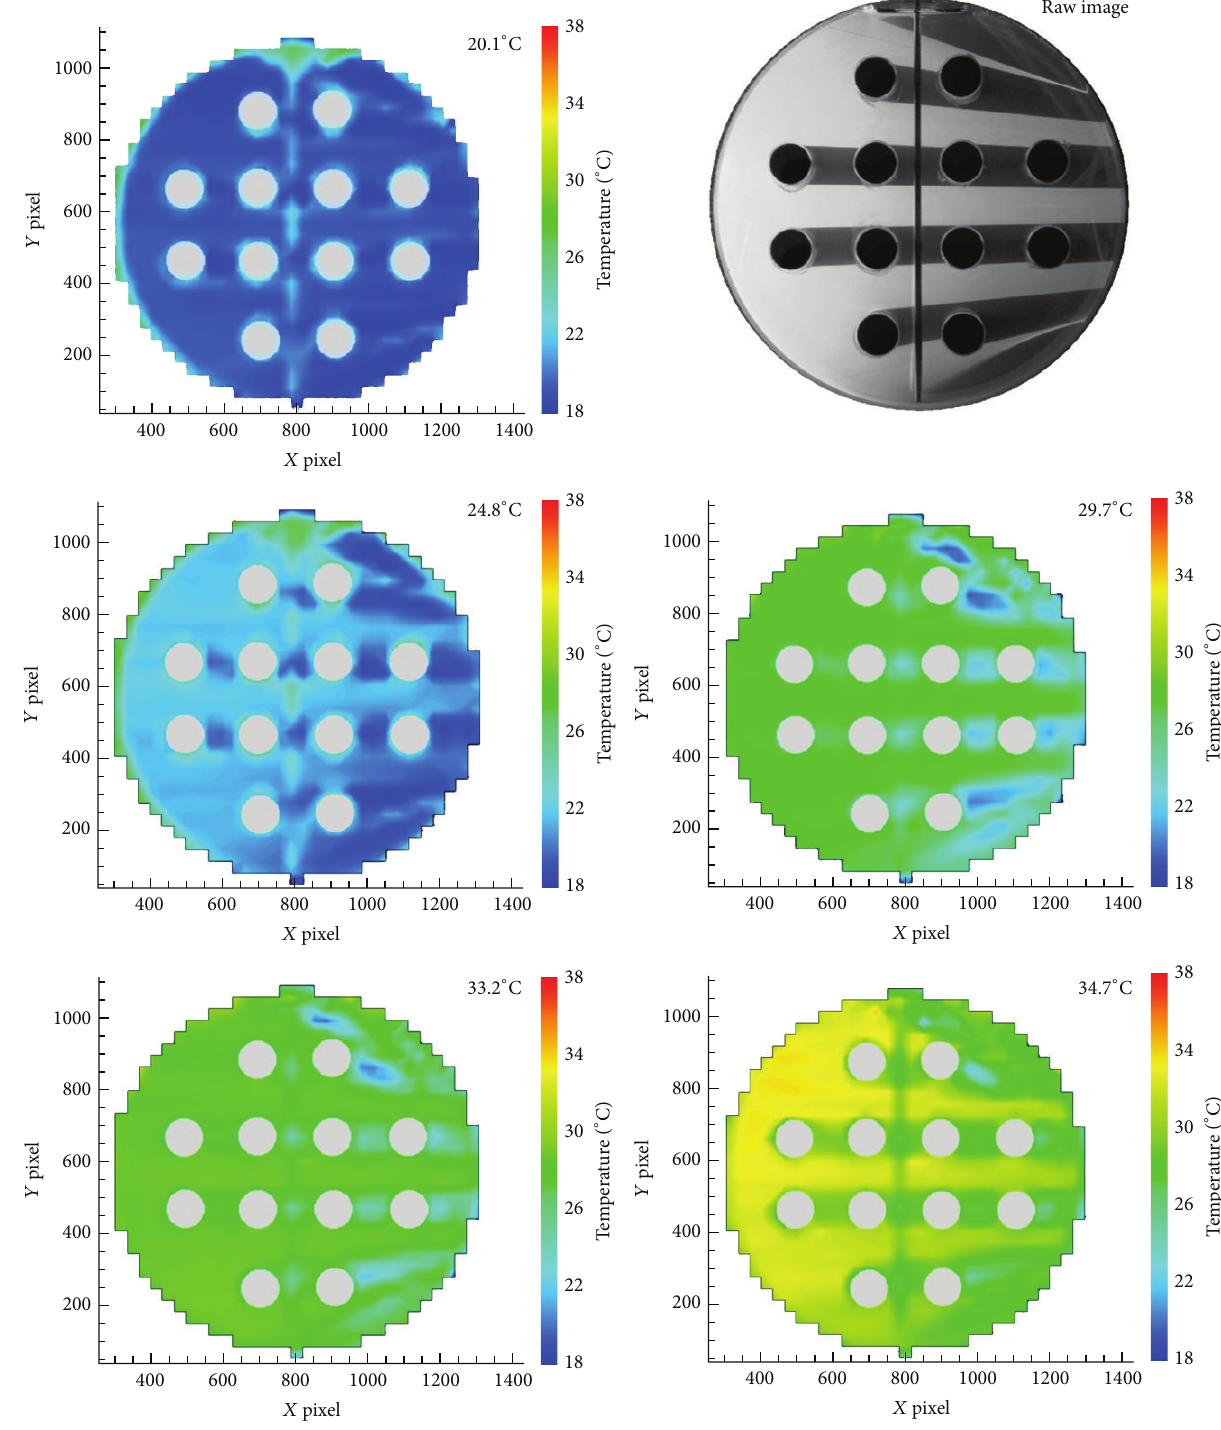
Figure 11: Variation of temperature measurements with different inlet water temperatures.